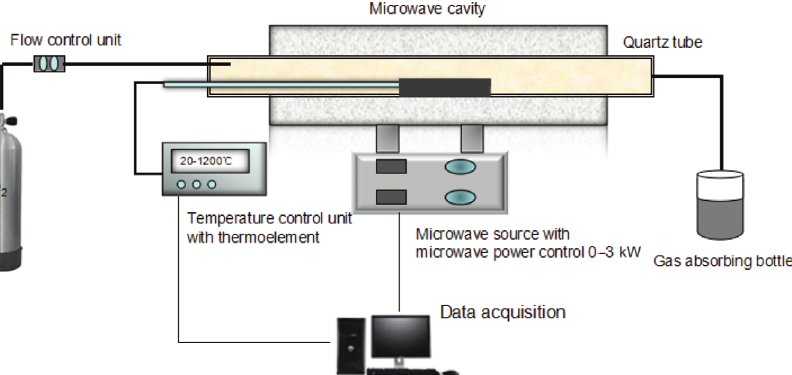
Figure 2: Schematic diagram of the microwave reactor system.